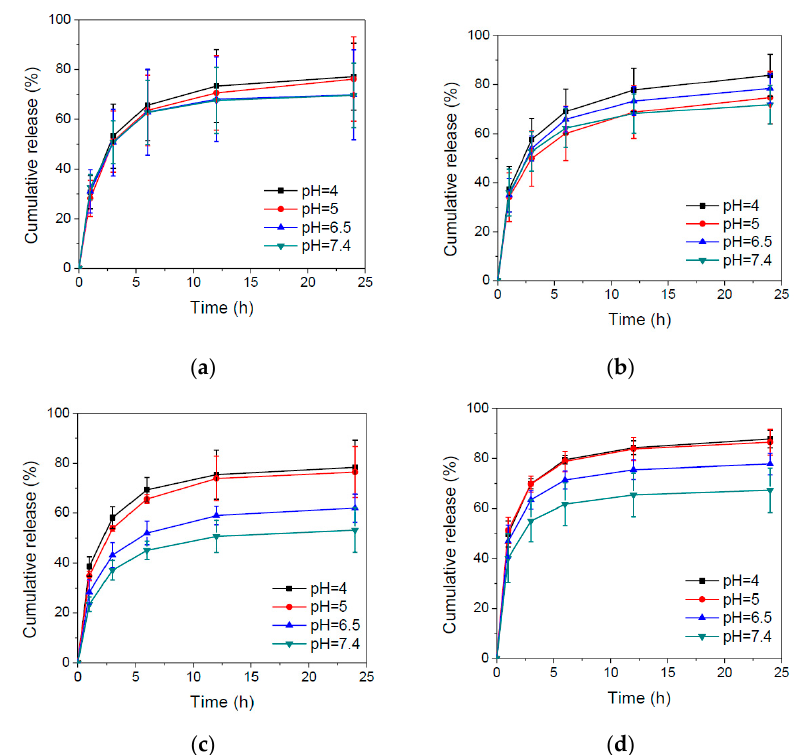
Figure 7. IMQ release profiles of ( a ) BD1, ( b ) BD5, ( c ) HBD1, and ( d ) HBD5 polymeric nanoparticles in various pH solutions.